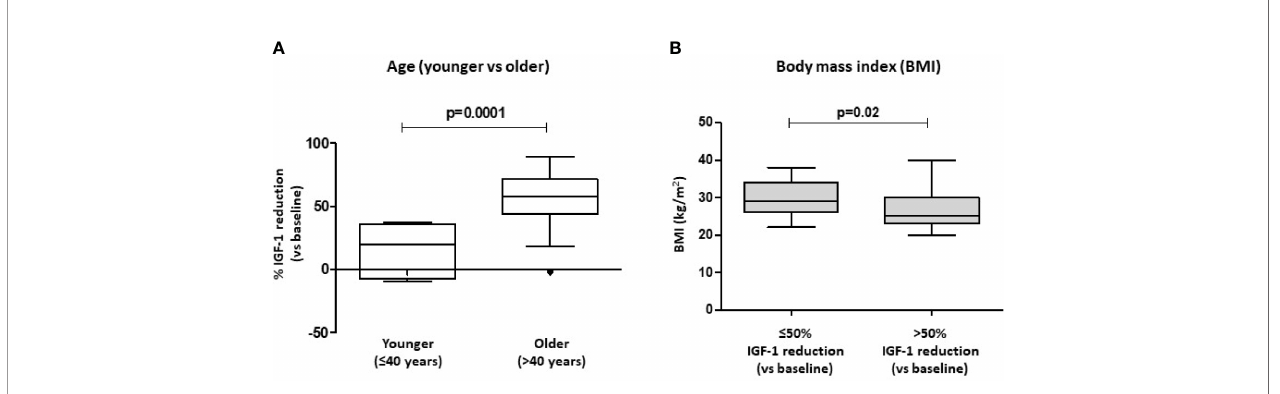
FIGURE 1 | Biochemical response after fi rst-line SRL treatment (6 months) with respect to patients ’ age and BMI. Patients were strati fi ed into younger (age ≤ 40 years) and older (>40 years) subjects. % IGF-1 reduction account for the relative IGF-1 reduction observed after 6-month therapy with fi st-generation SRLs (A) .